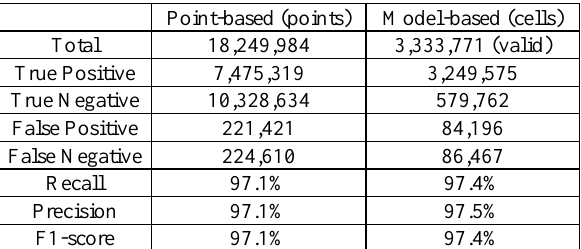
Table 3 Accuracy assessment of ground